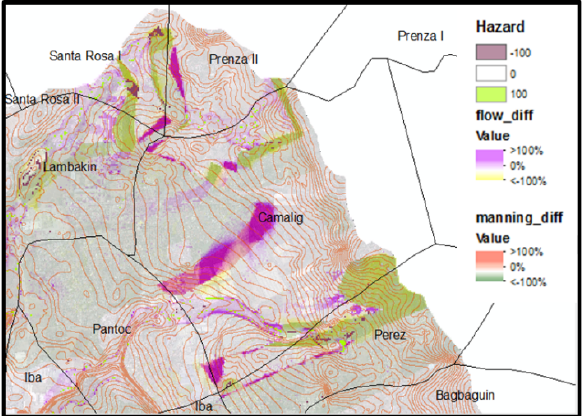
Figure 12. Change in Flooding due to Land Use change in